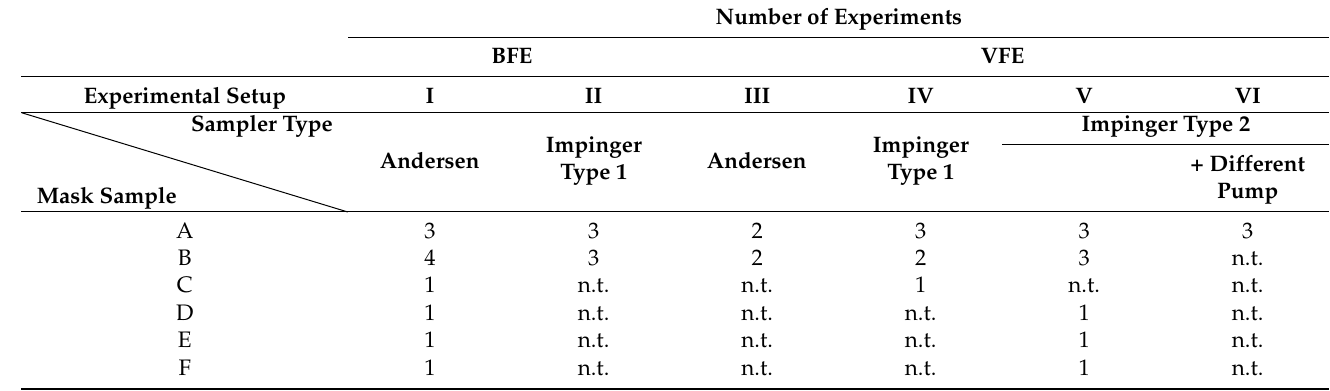
Table 1. Number of experiments in different experimental setups for each mask sample. Each experiment included 3–5 mask subsamples (supplementary Tables S1–S6). BFE, bacterial filtration efficiency; VFE, viral filtration efficiency; n.t., not tested. Number of Experiments BFE VFE Experimental